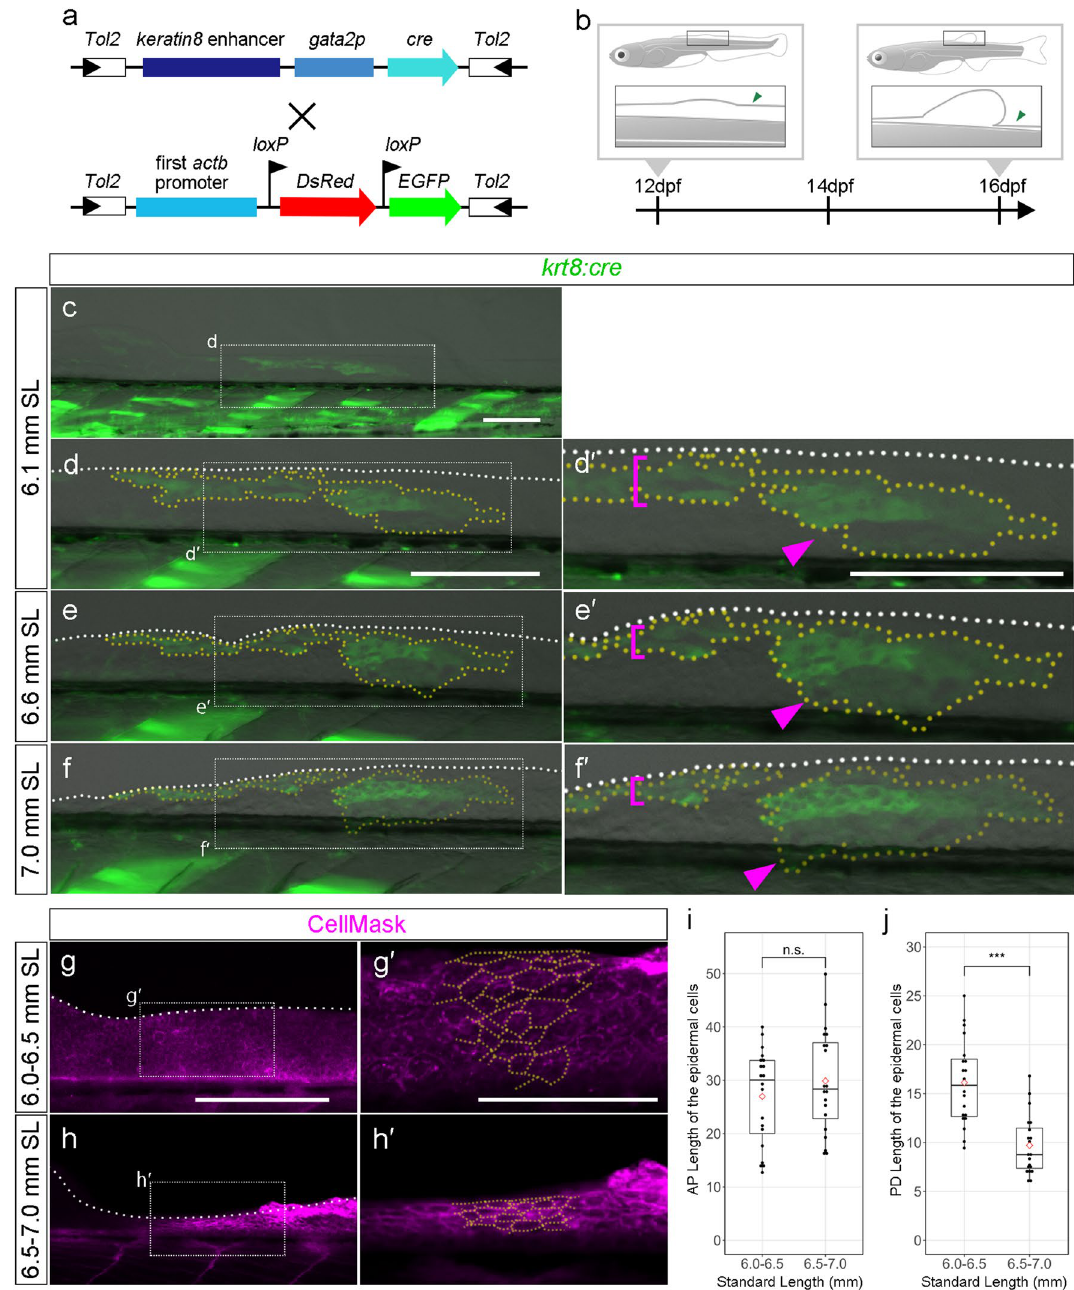
Figure 3. Cell-tracking analysis of the epithelial cells in the reducing LMFF area. ( a ) Schematic of the plasmid DNA construct used to generate the Tg. ( b ) Scheme of the Tg observation. ( c – f’ ) GFP-positive labelled cells in the reducing LMFF area at 6.1 mm SL ( c – d’ ), 6.6 mm SL ( e – e’ ), and 7.0 mm SL ( f – f’ ). The right panels ( d’ , e’ , f’ ) are magnified views of the dashed rectangles in the left panes ( d , e , f ), respectively. White dashed lines in ( d-f’ ) indicate outlines of the LMFFs. Yellow dashed lines indicate outlines of the EGFP-positive populations of epidermal cells. Magenta brackets in ( d’ , e’ , f’ ) indicate EGFP-positive populations of epidermal cells experiencing proximo-distal shrinking. Magenta arrowheads in ( d’ , e’ , f’ ) indicate EGFP-positive populations of epidermal cells migrating down to the trunk. ( g – h’ ) Cell morphology and distribution in the reducing LMFF area at 6.0–6.5 mm SL ( g – g’ ) and 6.5–7.0 mm SL ( h – h’ ). Cell membrane visualized by CellMask. The right panels ( g’ , h’ ) are magnified views of the dashed rectangles in the left panels ( g,h ), respectively. Yellow dashed lines indicate outlines of the epidermal cells. ( i,j ) Boxplots of cell length along the AP and PD axis in the reducing LMFF area. Whiskers in ( i ) and ( j ) show maximum and minimum values within 1.5 times the interquartile range. Boxes show the median and 25th and 75th percentiles. The P value in ( i ) and ( j ) is the result of Brunner-Munzel test ( P = 0.4407 and P = 8.34e-10). Scale bars in ( c,d,d’,g ) and that in ( g’ ) indicate 200 μm and 100 μm,